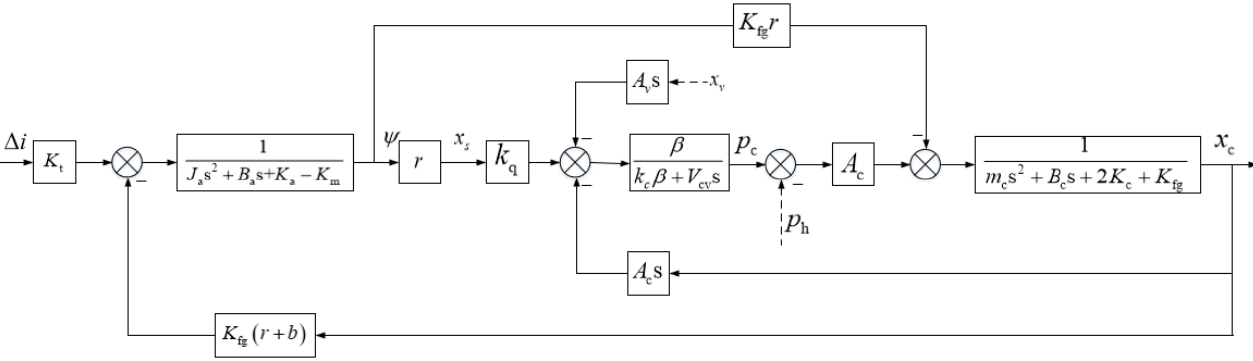
Figure 25. Block diagram of pressure servo valve pre-stage.